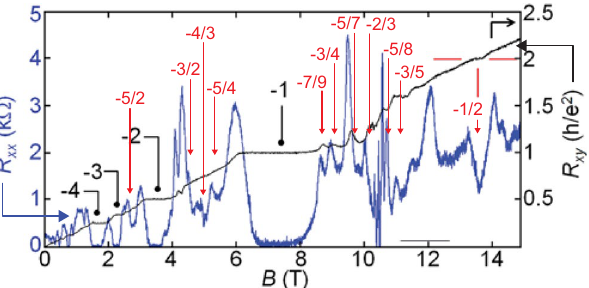
Figure 8. Observation of FQHE at T = 0.25 K in bilayer suspended graphene, magneto-resistance R xx (blue curve) and R xy (black curve) at the lateral voltage − 27 V, after experiment 4 . Shown in red is the fitting with the cyclotron braid group hierarchy (as in the upper part of Table 2) for mirror valence-band FQHE states, including ν = − 1 (the mirror fraction to ν = 1 ). [adapted with permission from ref. 4 , Copyright 2014 2 2 American Chemical Society, coloured fractions are